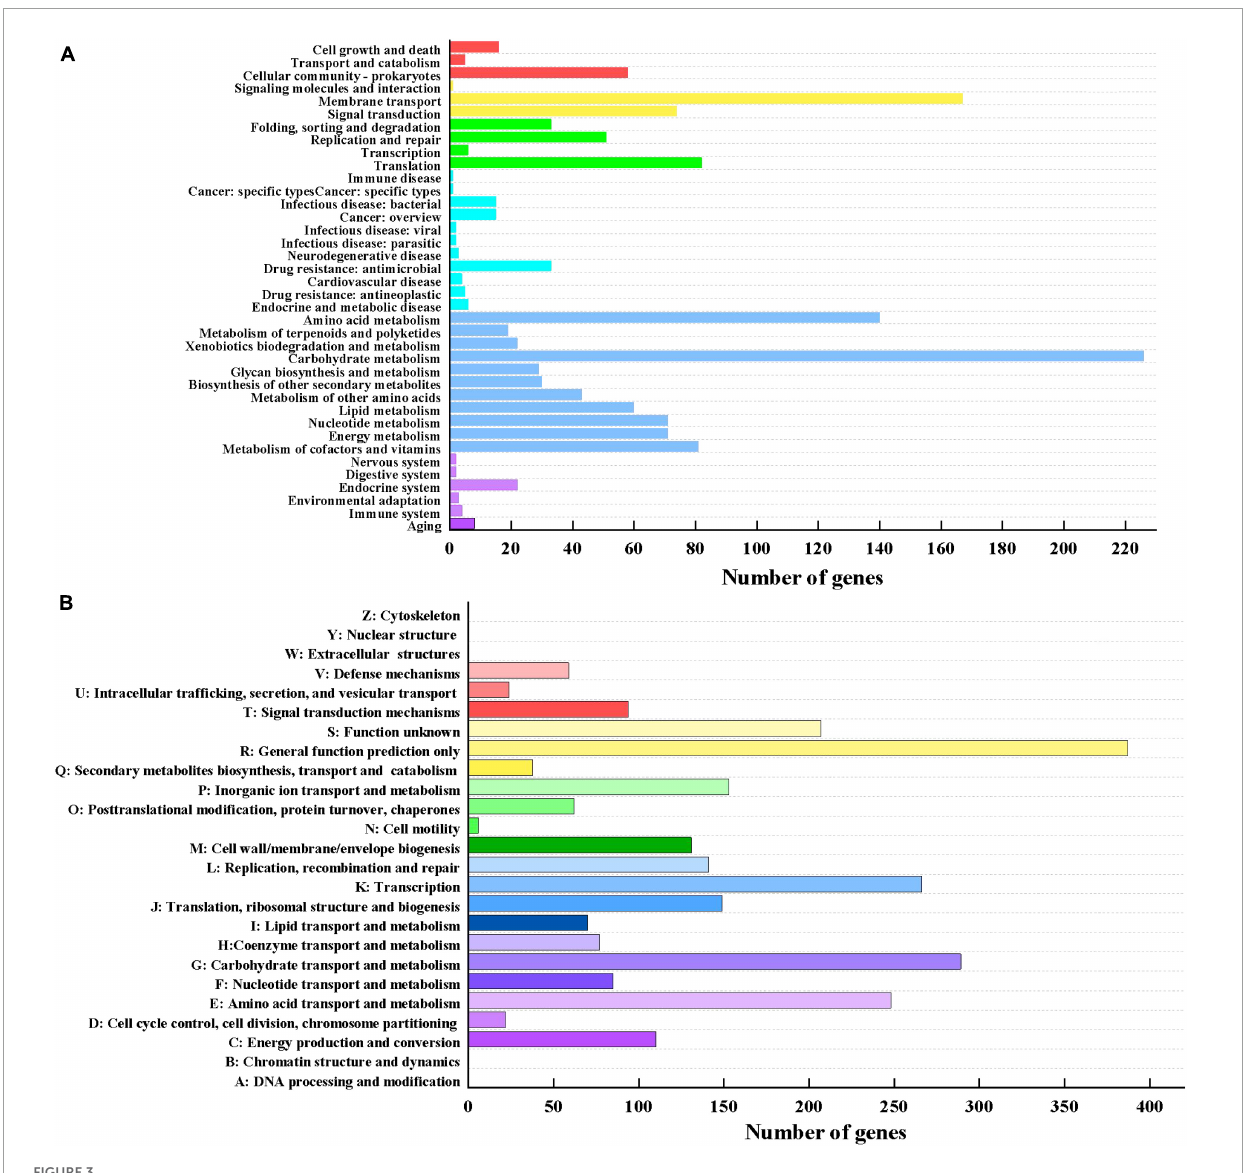
FIGURE3 (A) KEGG functional annotation of Lp. plantarum MC5. The six different colors from top to bottom represent cellular processes, environmental information processing, genetic information processing, human diseases, metabolism, and organismal systems, respectively. (B) COG functional annotation of Lp. plantarum MC5.